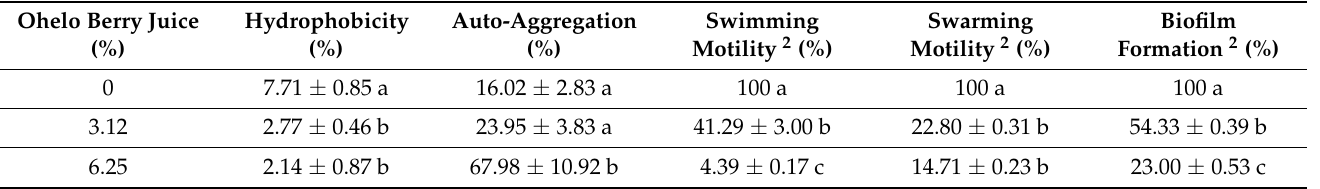
Table 3. Physicochemical properties and biofilm formation capability of L. monocytogenes in the presence of ohelo berry juice 1